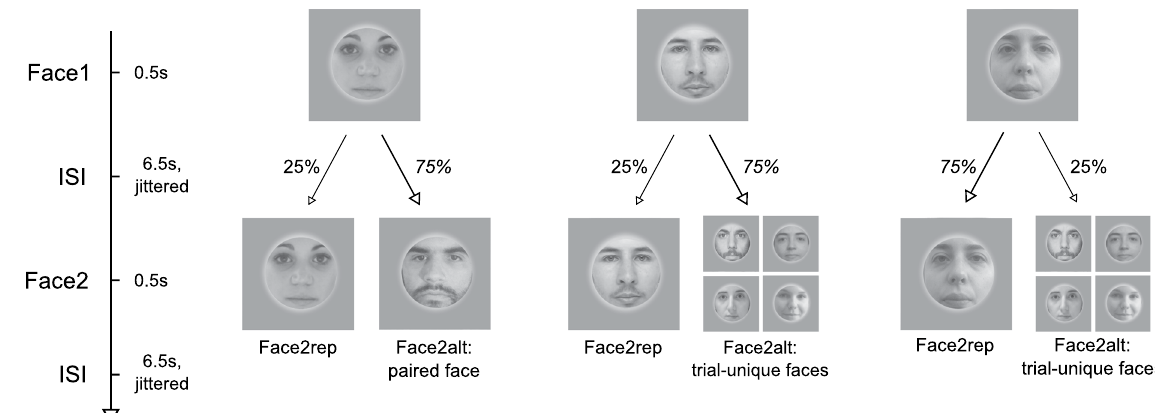
Figure 1. Overall experimental design. Each trial consisted of two faces, each presented for 0.5 s, and each followed by a long Inter-Stimulus Interval (ISI; 6.5 s, jittered). The first face (Face1) was either repeated (Face2rep, Repetition Trials) or followed by a different face (Face2alt, Alternation Trials) with variable contingencies depending on block type. Face2alt was specifically paired with Face1 in Prediction Blocks, while unpredictable and trial-unique in Repetition & Alternation Blocks. Participants were not informed of these contingencies. All faces were randomly tilted 1.5° clockwise or counterclockwise, which participants had to report by pressing a response button after the offset of each